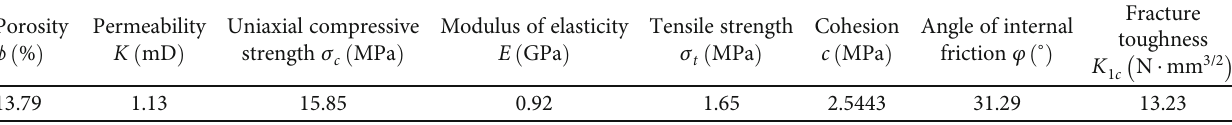
Figure 3: Manufacture of specimens [64]. Table 1: Physical and mechanical parameters of the cement